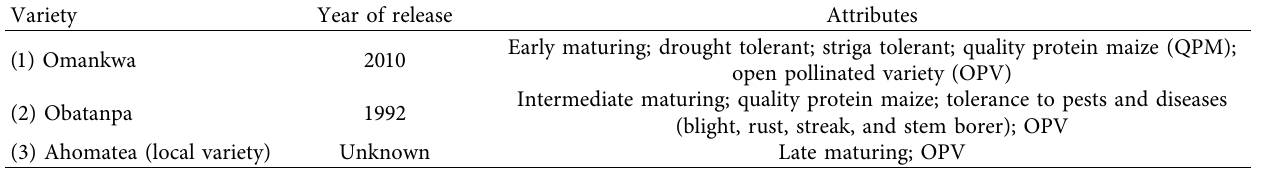
Table 3: Attributes of maize varieties used in the